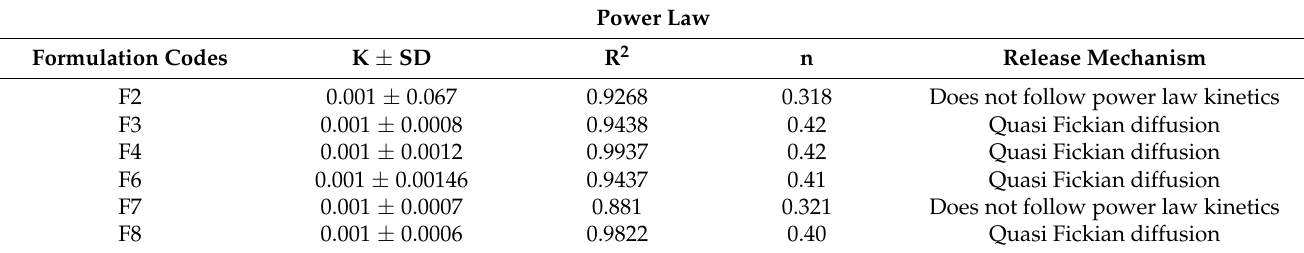
Table 10. Release kinetics of metronidazole floating effervescent tablets in 0.5% NaCl.